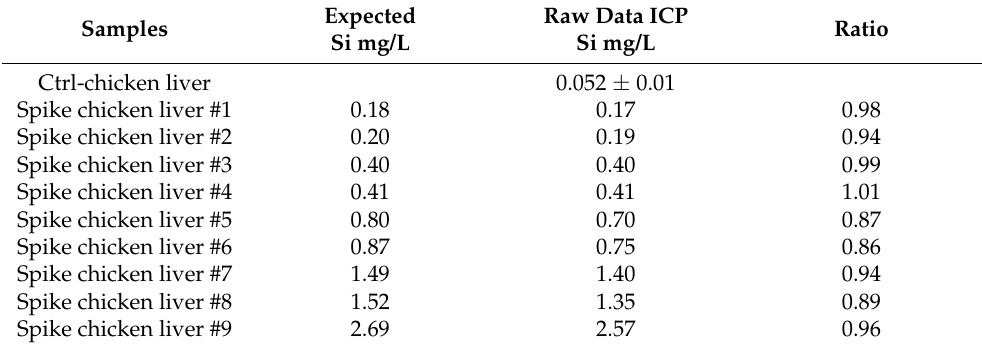
Table 5. Recovery ratios for chicken liver after digestion in HNO 3 /H 2 O 2 .